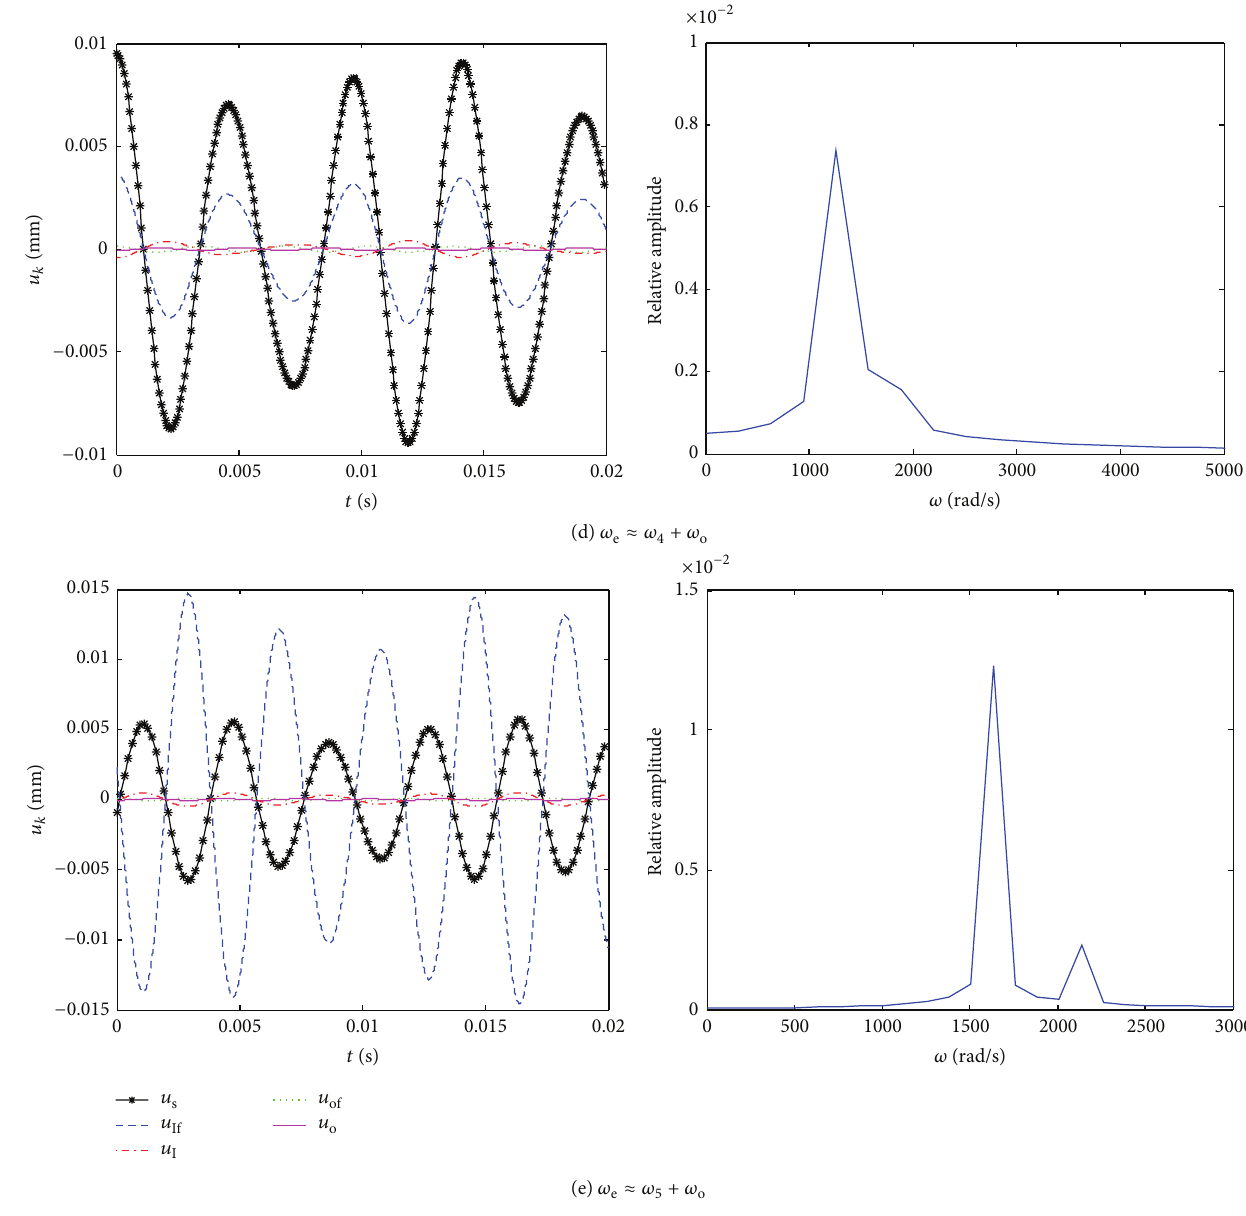
Figure 6: Combination resonance of the EIMG system with 𝜔 e ≈ 𝜔 𝑘 + 𝜔 o